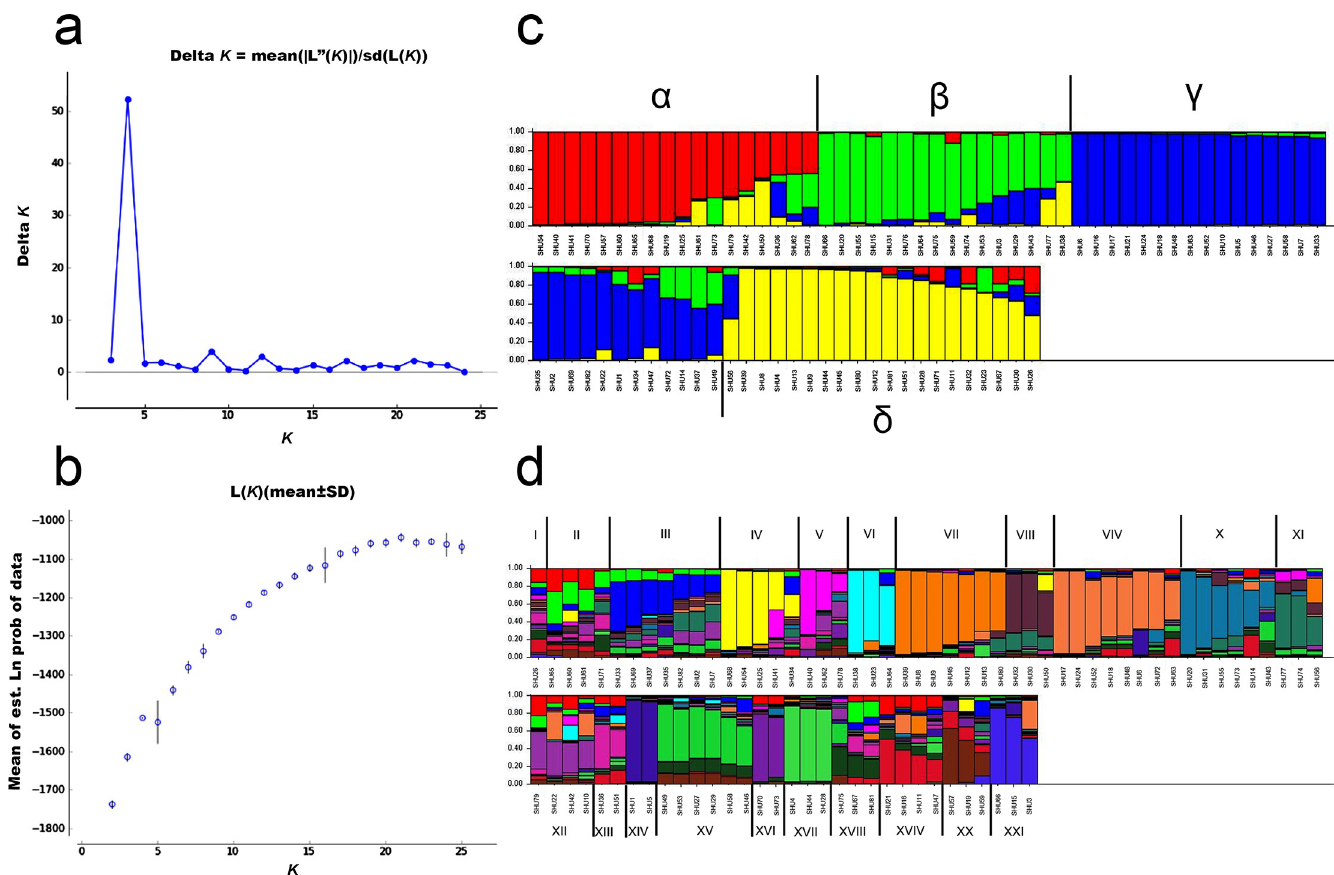
Fig 2. Population structure of the captive population of 82 individuals of Hume’s pheasant ( Syrmaticus humiae , Hume 1881). (a). Evanno’s Δ K graph (b). Mean ln P ( K ) graph, and Structure bar plots depicting model-based clustering results for inferred K = 4 (c) and K = 21 (d). Inferred genetic clusters are displayed as different colors. Each vertical bar on the x -axis represents an individual, and the y -axis presents the proportion of membership (posterior probability) in each genetic cluster. Recovered Hume’s pheasants are superimposed on the plot, with black vertical lines indicating the boundaries. Detailed information for all Hume’s pheasant individuals is presented in S2